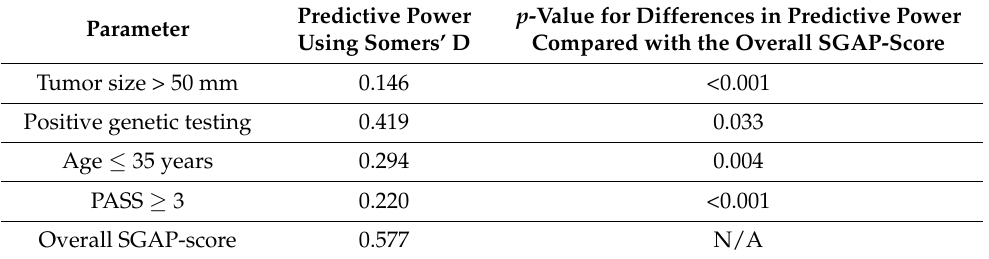
Table 2. Predictive performance of the four dichotomous predictive factors and overall SGAP-score. Abbreviations: N/A, not applicable; PASS, Pheochromocytoma of the Adrenal gland Scaled Score; SGAP, Size–Genetic–Age–PASS.